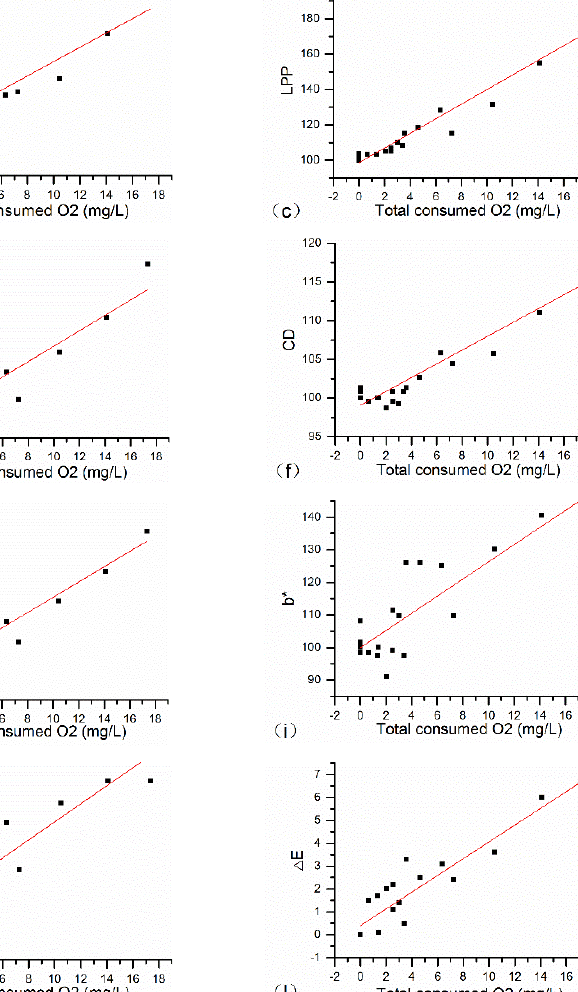
For CIELab parameters, b* and H*ab increased by around 2.3%, while L* decreased slightly